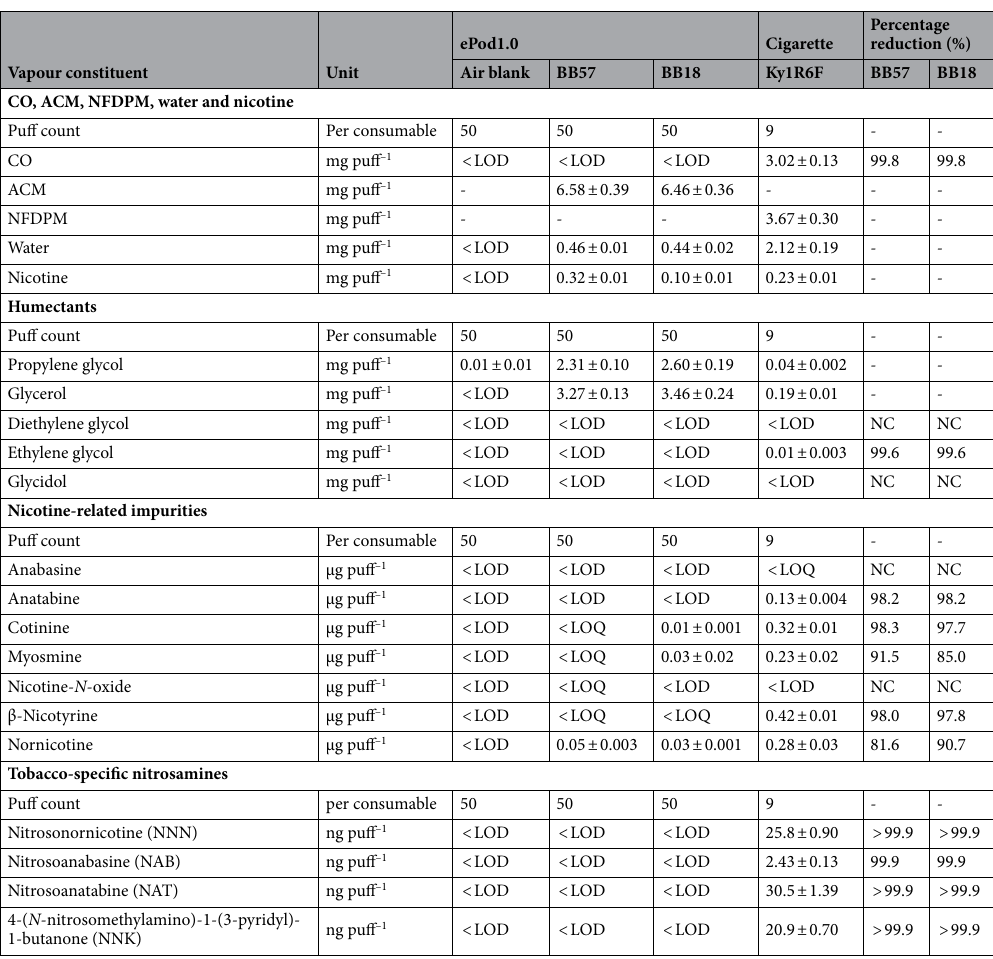
Table 1. CO, ACM, NFDPM, water, nicotine, humectants and related impurities and toxicants: per-puff concentration of e-cigarette vapour emissions, respective method air blanks and Ky1R6F cigarette smoke. Values are presented as mean ± standard deviation (n = 5) with the exception of ACM (n = 85). Percentage reduction of e-cigarette emissions relative to Ky1R6F cigarette smoke. CO carbon monoxide, ACM aerosol collected mass, NFDPM nicotine-free dry particulate matter, NC not calculated, LOD limit of detection, LOQ limit of quantification. More information about the analytical methods and respective LODs and LOQs are under the Supplementary Information (Tables S1 and